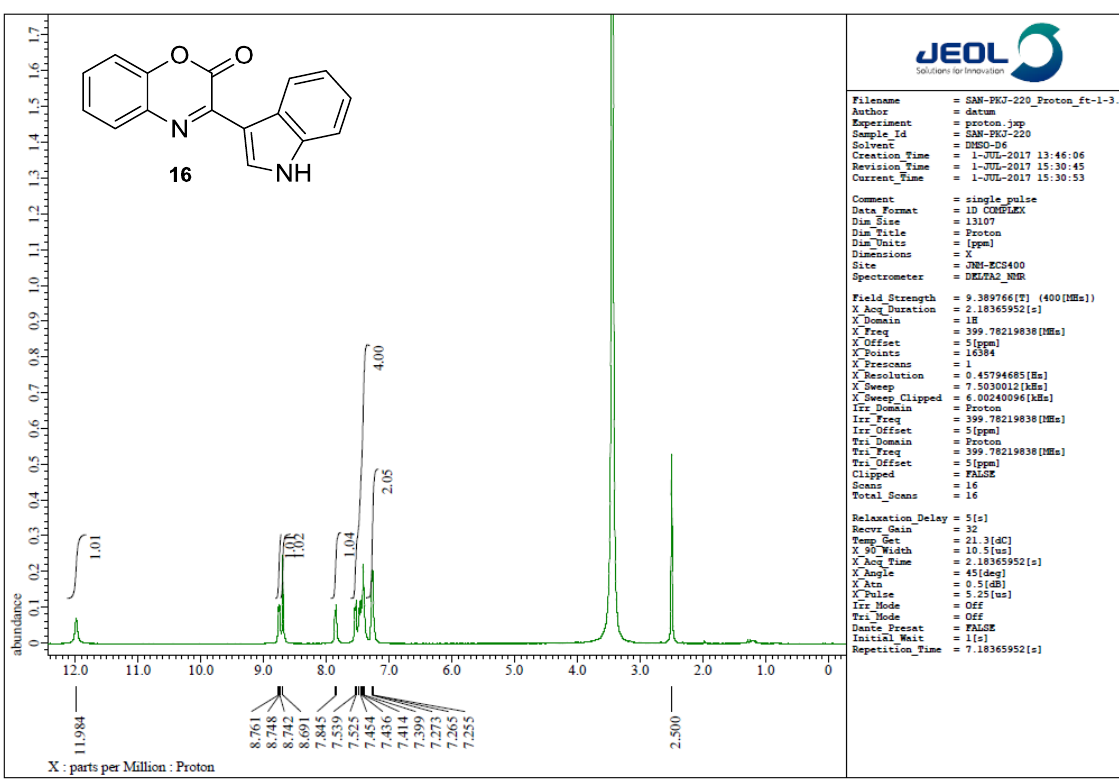
Figure 45 . 1 H NMR Spectra of Compound